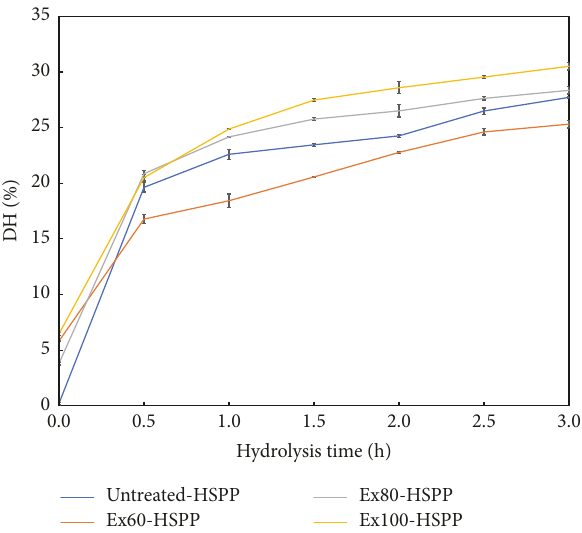
Figure 1: DH of hydrolyzed samples with/without